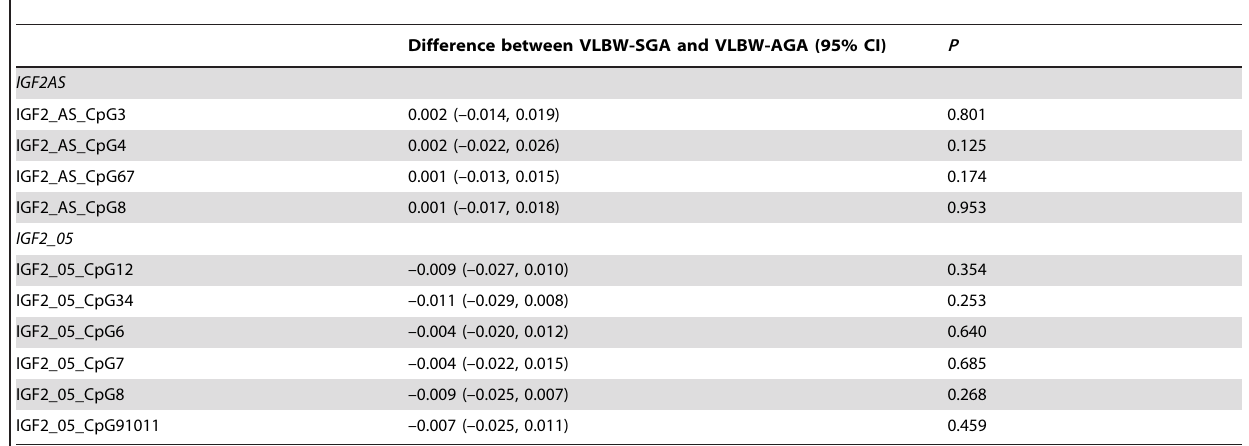
Table 5. Differences in methylation fractions at different IGF2 CpG units between VLBW subjects born SGA and VLBW subjects born AGA by linear